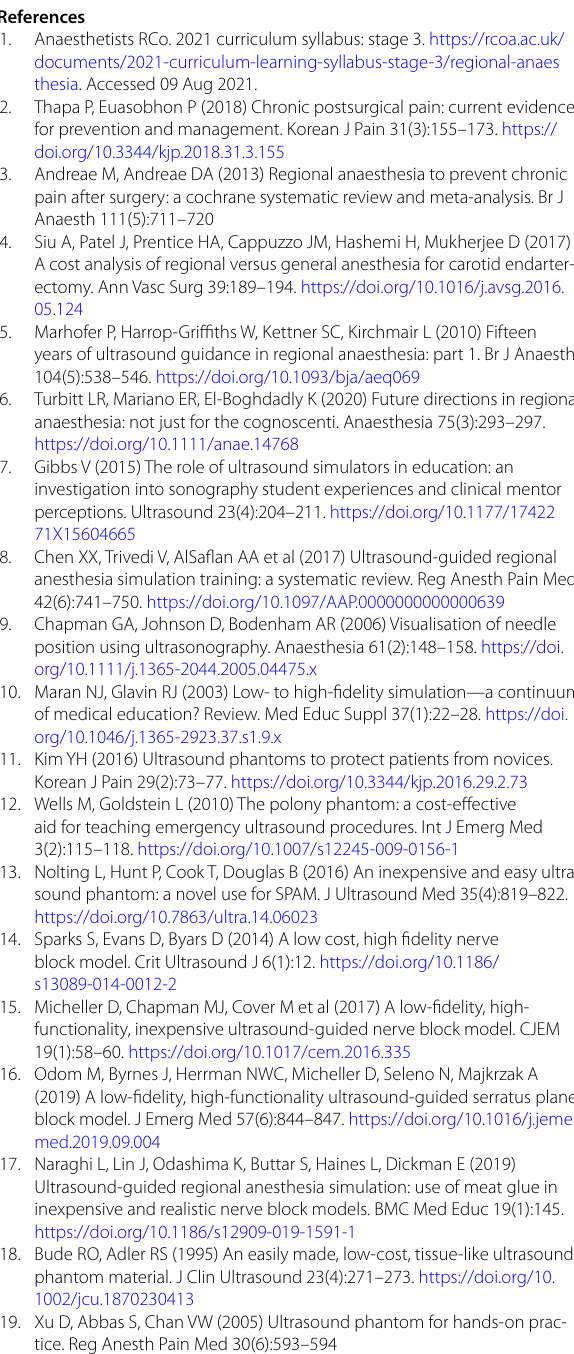
Table 2 Mean realism scores for the ‘look’ and ‘feel’ of each specimen